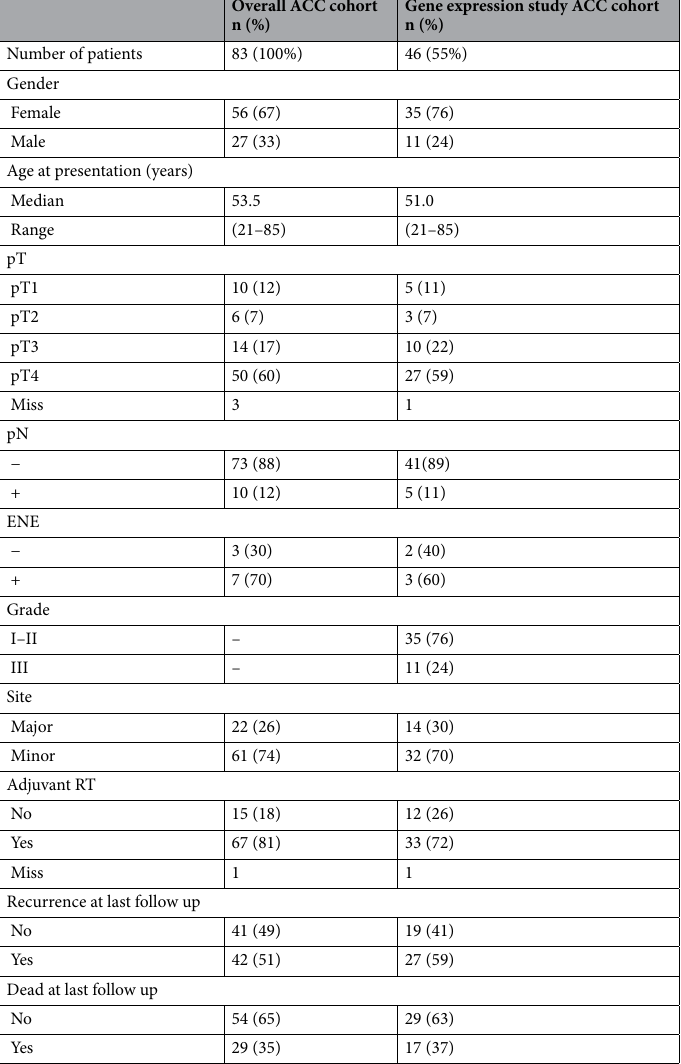
Table 1. Patient cohort description. ENE extra nodal extension, RT radiotherapy, N lymph